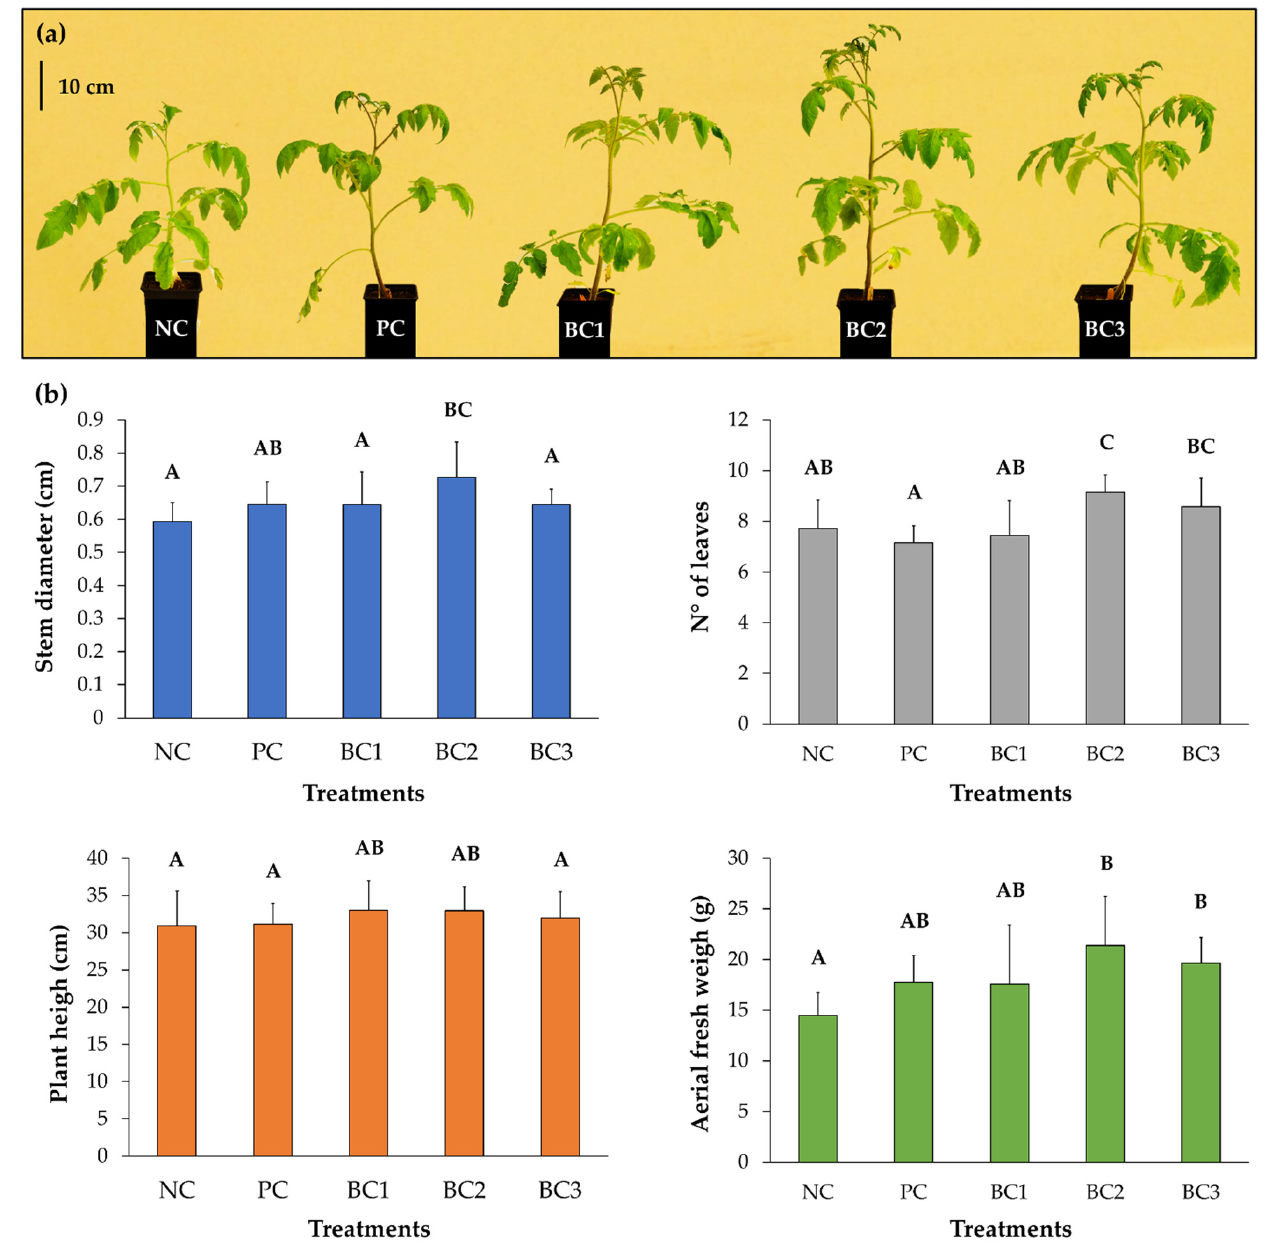
Figure 6. Effects of selected bacterial consortia on tomato plant growth. Tomato seedlings were arranged in peat pots and inoculated every 2 weeks in roots and at the leaves. ( a ) Representative photograph of tomato plants assay. ( b ) Graphs of parameters evaluated for tomato plants growth. Each value is a mean ± SD of seven independent replicates. Significant differences were analyzed by one-way ANOVA followed by LSD Fisher test. Means with different letters indicate significant differences ( p < 0.05). Abbreviations: NC, negative control; PC, positive control (Nutrisac); BC1-3, bacterial consortium 1, 2, and 3, respectively.